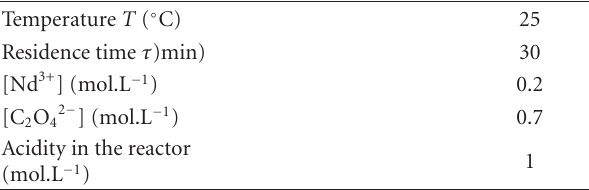
Figure 1: Experimental precipitator diagram. Table 1: Operating parameters of precipitation